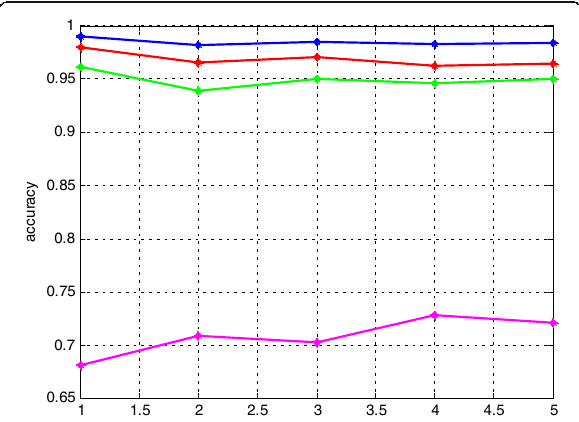
Fig. 2 Accuracy from different k of k -NN. As shown in the figure, the blue line that is the highest recognition rate denotes the recognition rate of combined features. The red line is the recognition rate of color features. The green line is the recognition rate of texture features and the purple line, i.e., the recognition rate of shape features, denotes the lowest recognition rate